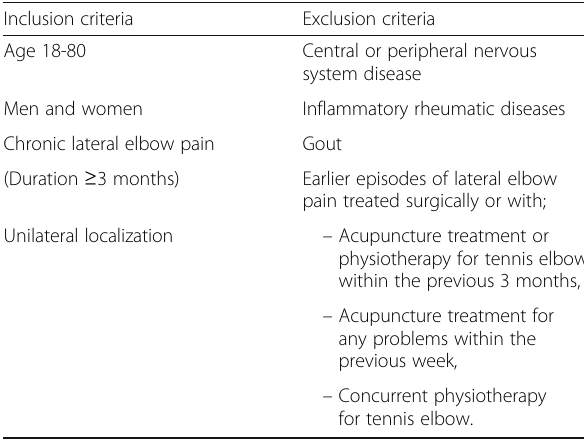
Table 1 Inclusion and exclusion criteria used to select participants for the clinical